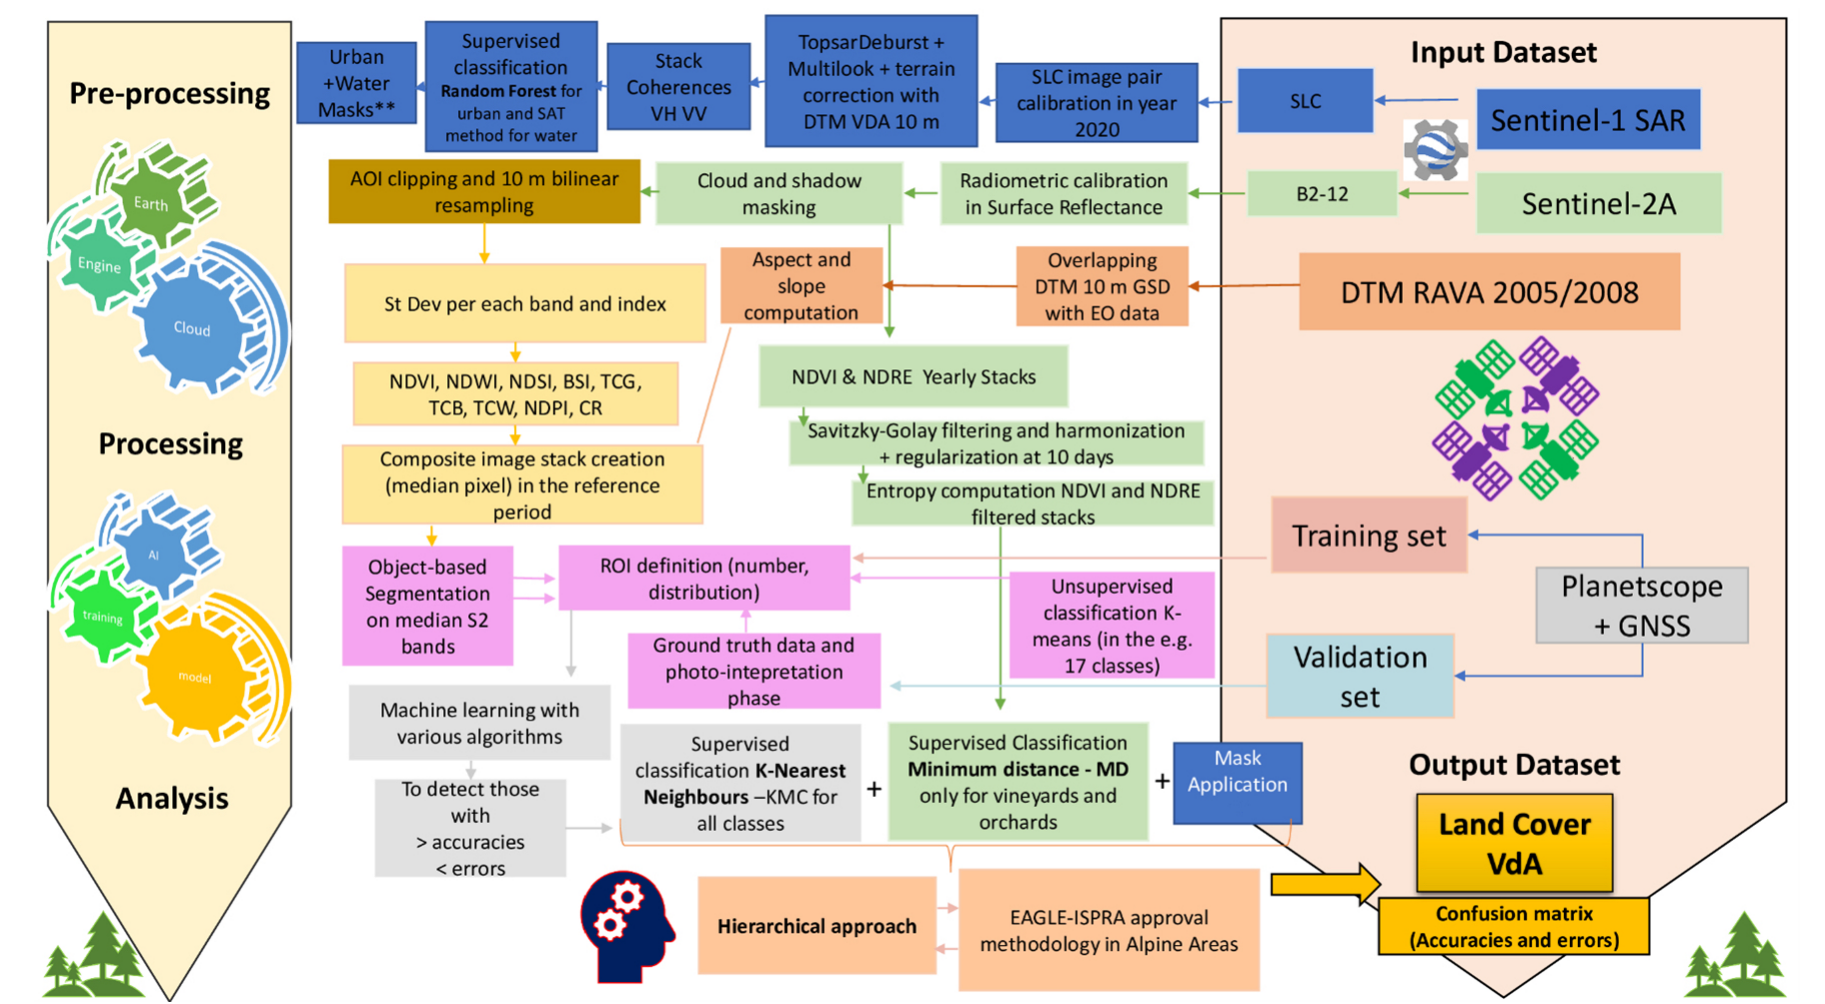
Figure 5. Workflow methodology developed to map EAGLE Land Cover in Alpine